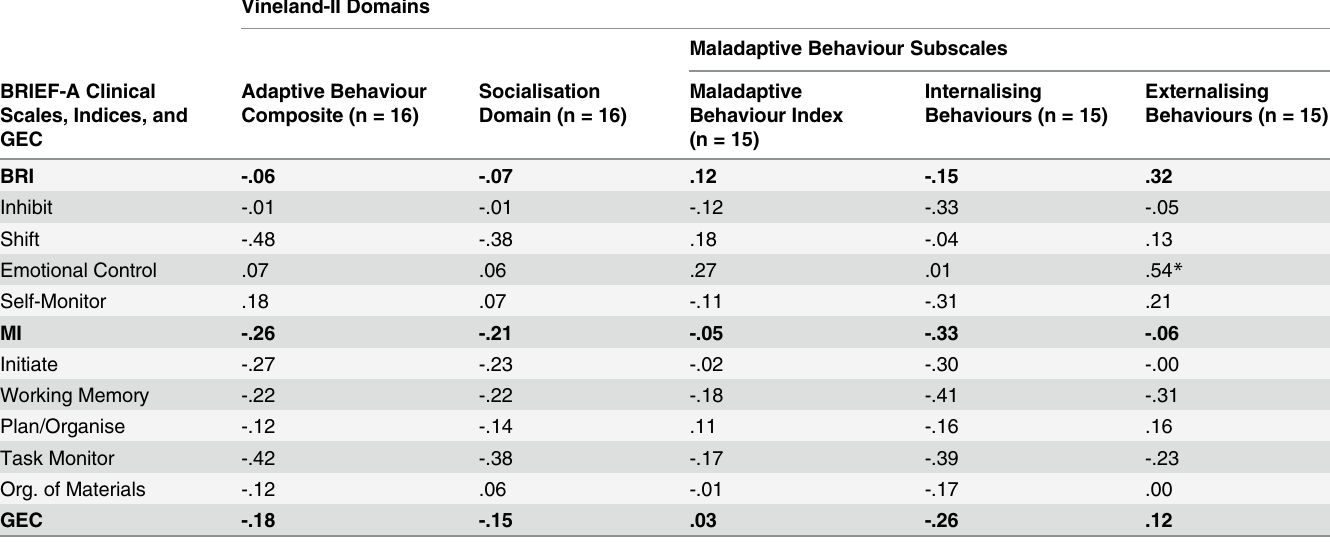
Table 5. Correlations Between the Vineland-II and the BRIEF-A (T